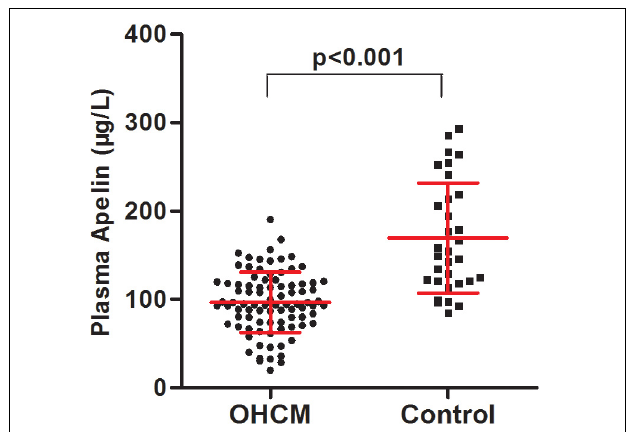
FIGURE 1 | The patients with obstructive hypertrophic cardiomyopathy had lower plasma apelin levels in comparison with control subjects.